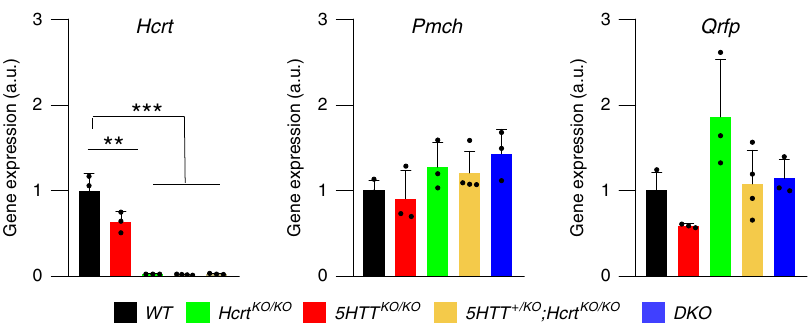
Fig. 6 Inactivation of 5HTT gene leads to partial HCRT de fi ciency. qPCR quanti fi cation of hypothalamic RNA. Hcrt is largely downregulated in 5HTT KO/KO mice as compared to WT littermates. Values are mean ± SEM, n = 3 (one-way ANOVA, genotype F (4, 11) = 64.79, P < 0.0001, followed by Dunnett ’ s test, ** P < 0.01; *** P < 0.001). DKO : n = 3, 5HTT KO/KO : n = 3, Hcrt KO/KO : n = 3, 5HTT + /KO ;Hcrt KO/KO : n = 4 and WT : n =